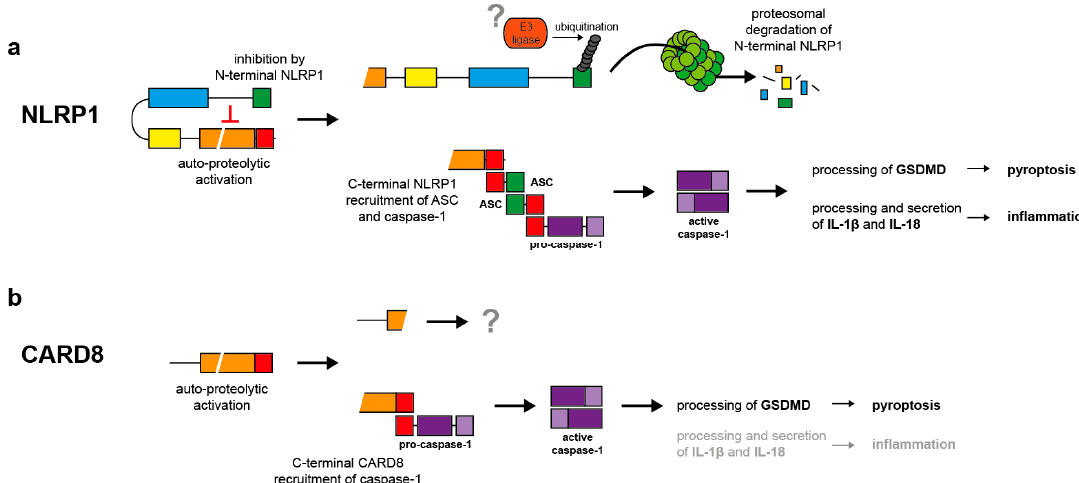
Figure 2. Mechanisms of NLRP1 and CARD8 activation. ( a ) NLRP1 activation is initiated by self-processing in the FIIND. However, the aminoterminal fragment inhibits the carboxyterminal e ff ector protein containing the CARD by a non-covalent interaction. Upon ubiquitination of the aminoterminal inhibitory fragment by unknown ubiquitin ligases, the latter is degraded by the proteasome. The liberated e ff ector fragment induces ASC speck formation, followed by caspase-1 activation and in turn processing of proIL-1 β and -18 and gasdermin D (GSDMD). Secretion of the cytokines induces inflammation supported by GSDMD-induced pyroptosis. ( b ) Activation of CARD8 is poorly understood. Most likely, self-processing induces direct activation of caspase-1 without participation of ASC. In contrast to NLRP1, CARD8-induced caspase-1 activation causes mainly pyroptosis by GSDMD cleavage rather than processing of proIL-1 β and -18.